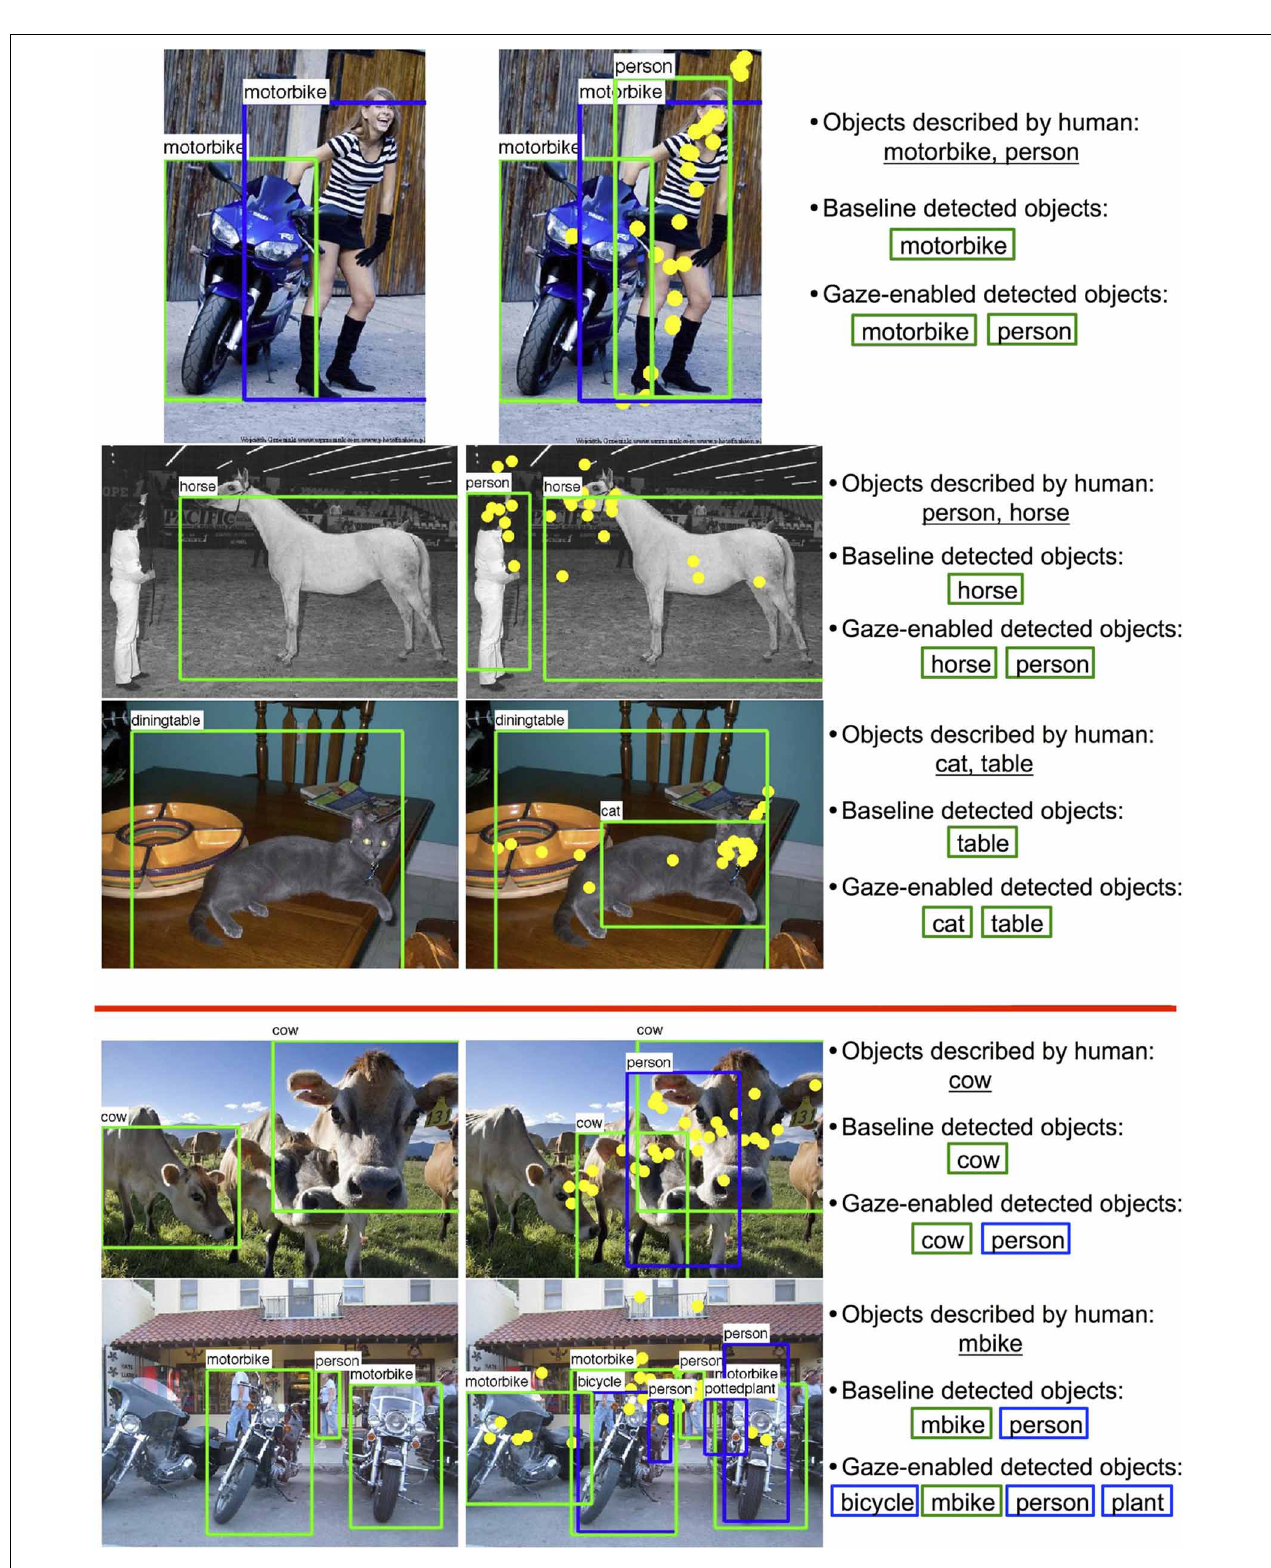
FIGURE 13 | Results of annotation prediction on the Pascal dataset. Left images: Baseline detection, Right images: Gaze-enabled detection.